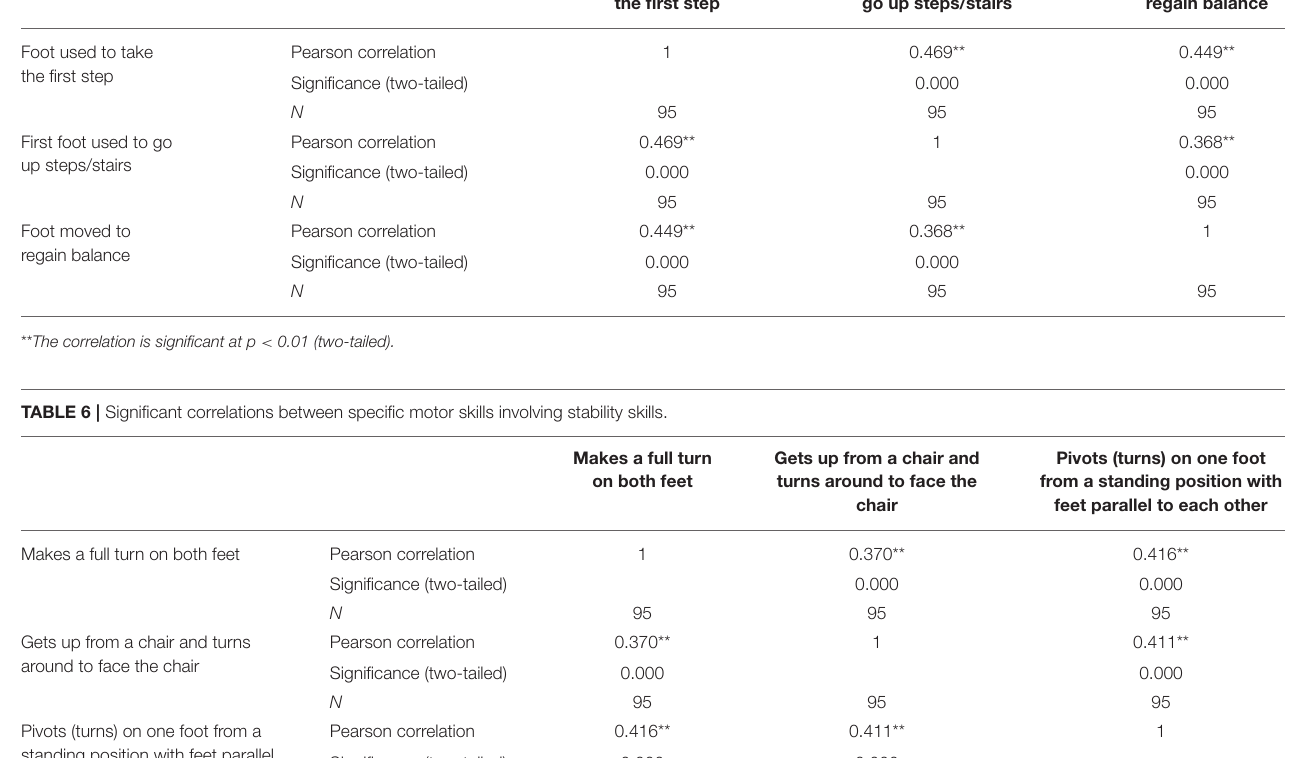
Foot used to take the first step